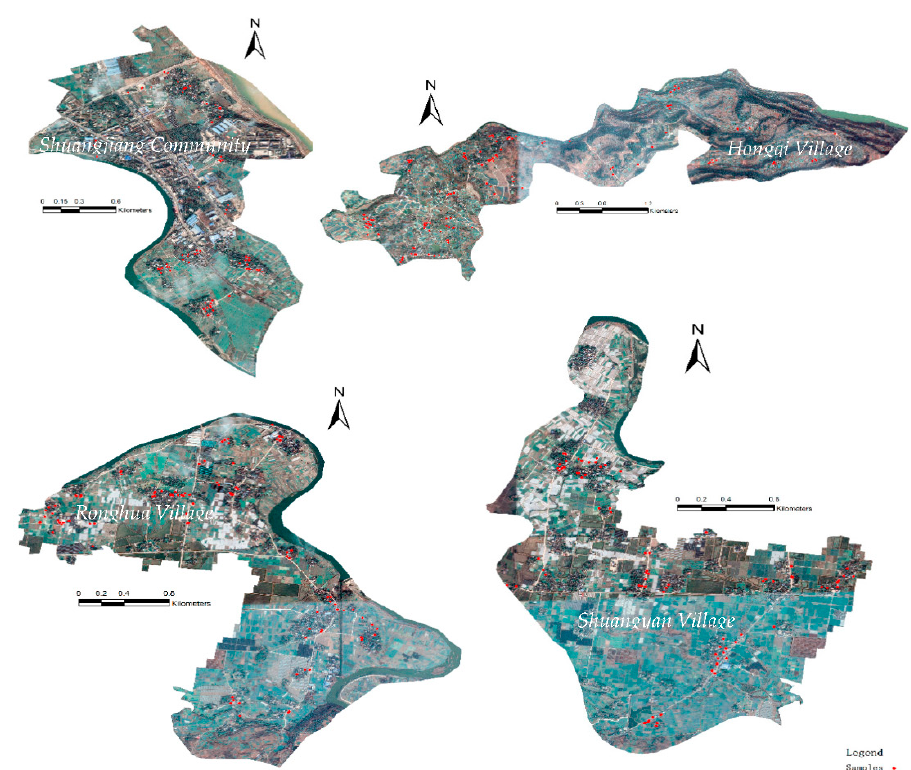
Figure 2. Location distribution map of respondents.